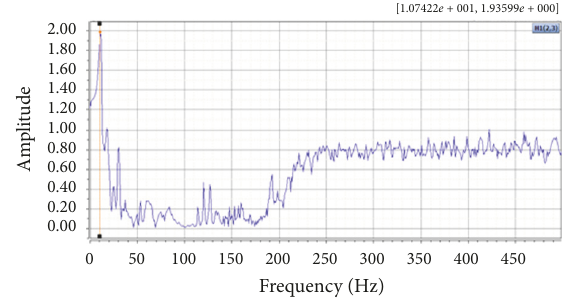
Figure 20: Frequency response of the MRE vibration absorber.